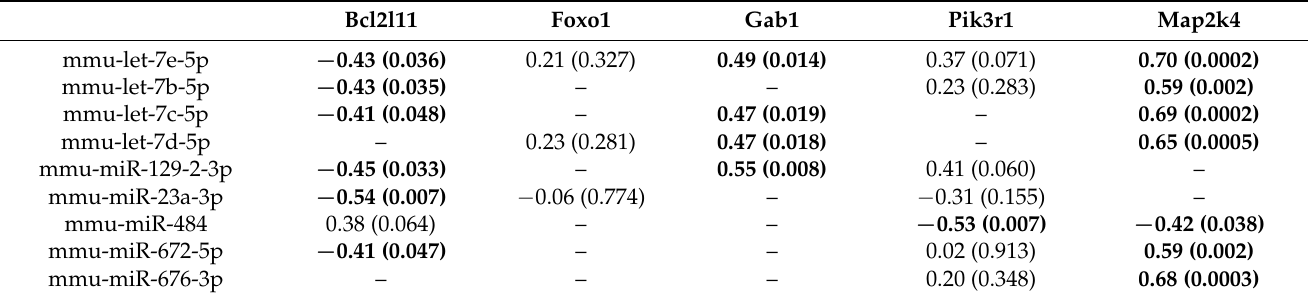
Table 1. Correlation matrix of miRNAs and mRNAs expression changing following stress in a genotype-dependent manner.